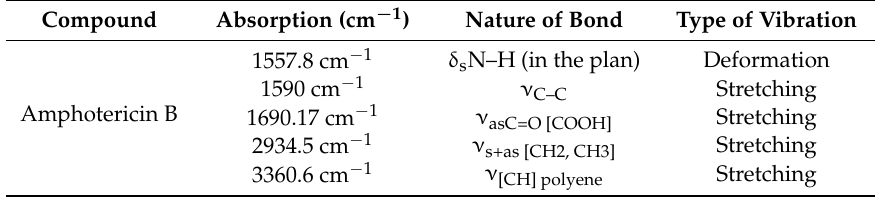
Table 3. Characteristic bands of amphotericin B in infrared